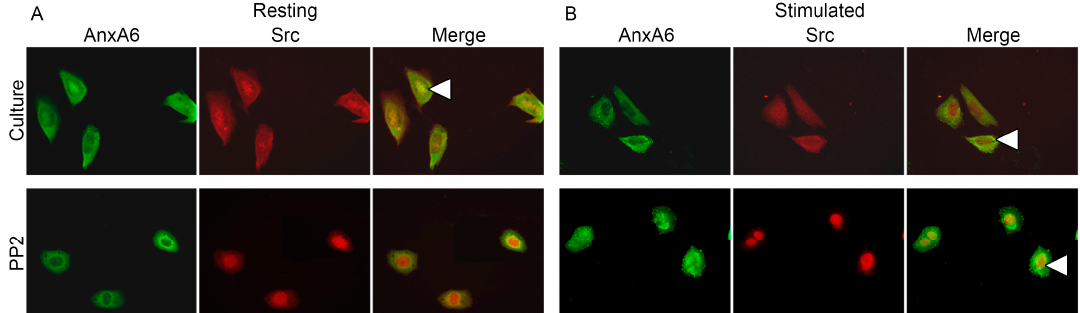
Figure 6. Co-localization of AnxA6 with Src in Saos-2 cells, non-treated or treated with different inhibitors, in resting conditions ( A ) or after seven-day stimulation with AA and β -GP ( B ). The cells were incubated with appropriate antibodies: mouse monoclonal anti-AnxA6 linked with goat-anti mouse IgG-FITC and rabbit polyclonal anti-Src linked with goat anti-rabbit IgG-TRITC and observed under an Axio Observer Z1 fluorescent microscope (Carl Zeiss, Oberkochen, Germany) with phase contrast and appropriate fluorescent filters, magnification 240×. The yellow color and arrowheads on the merge images indicate protein co-localization. Data of a typical experiment are presented.